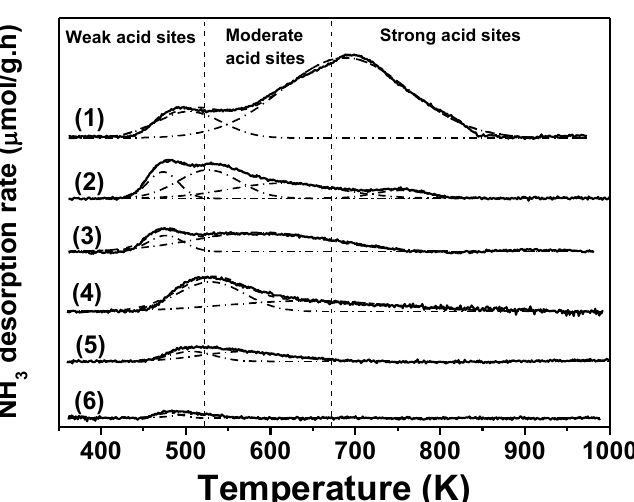
Figure 4. NH 3 -TPD profiles of the calcined supports and reduced Cu-based samples: (1) CuMgAl, (2) Cu/Al 2 O 3 -I, (3) Al 2 O 3 , (4) Cu/SiO 2 -PD, (5) Cu/SiO 2 -I, (6) SiO 2 .